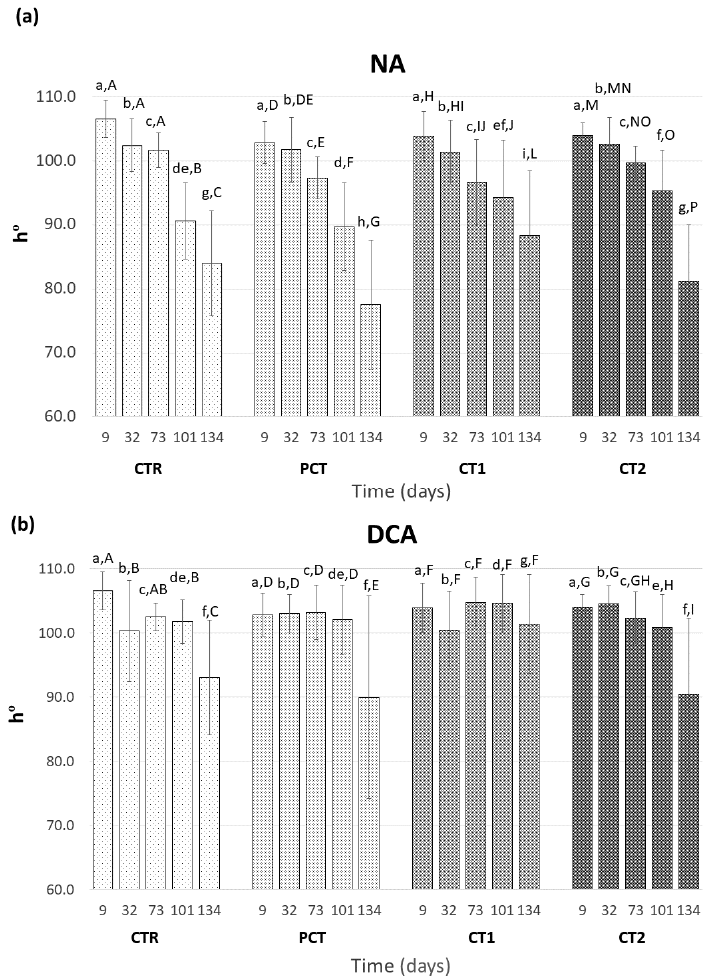
Figure 5. Evolution of the hue angle (h ◦ ) of “Rocha” pear at 9, 32, 73, 101, and 134 days. ( a ) NA (normal atmosphere); ( b ) DCA (dynamic controlled atmosphere) storage conditions. For each type of storage, four coating conditions are presented as follows: CTR (control), PCT (pectin), CT1 (coating 1), and